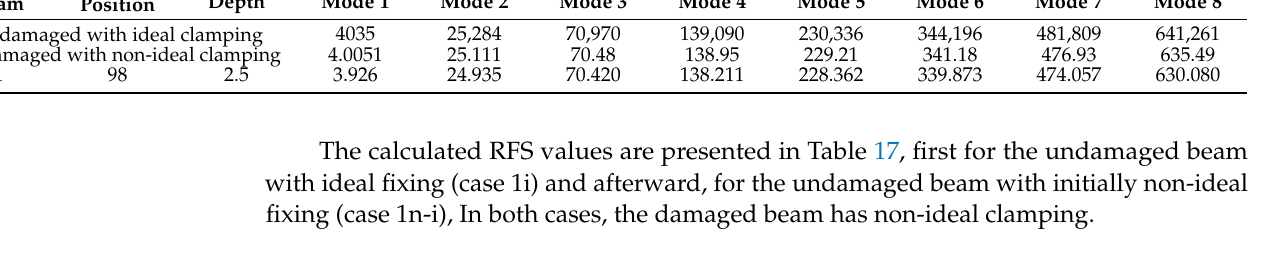
Table 17. Calculated RFS values for the improperly clamped damaged